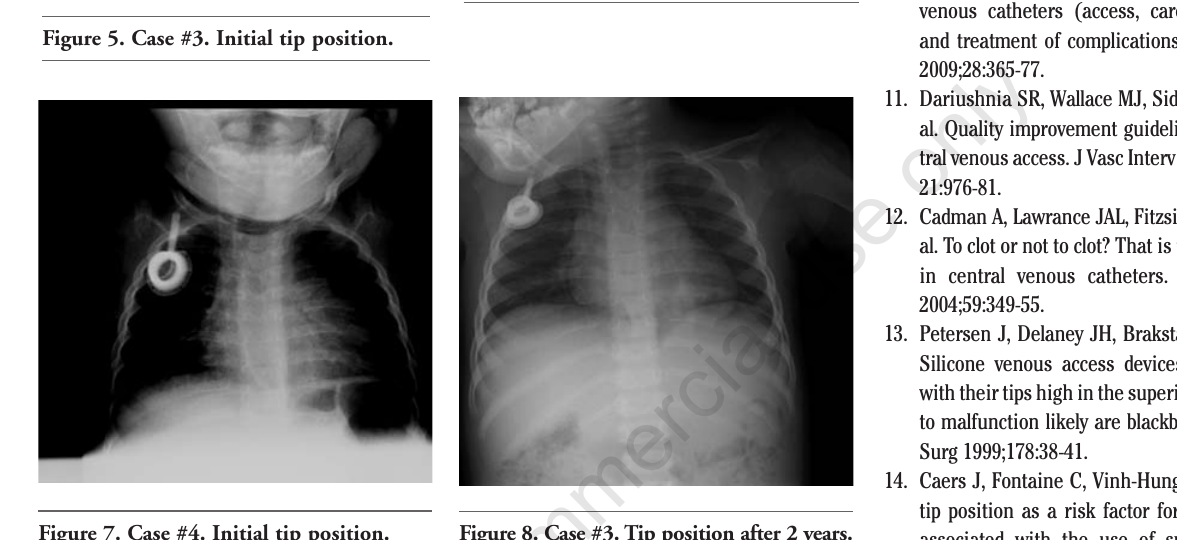
Figure 6. Case #3. Tip position after 5 years.